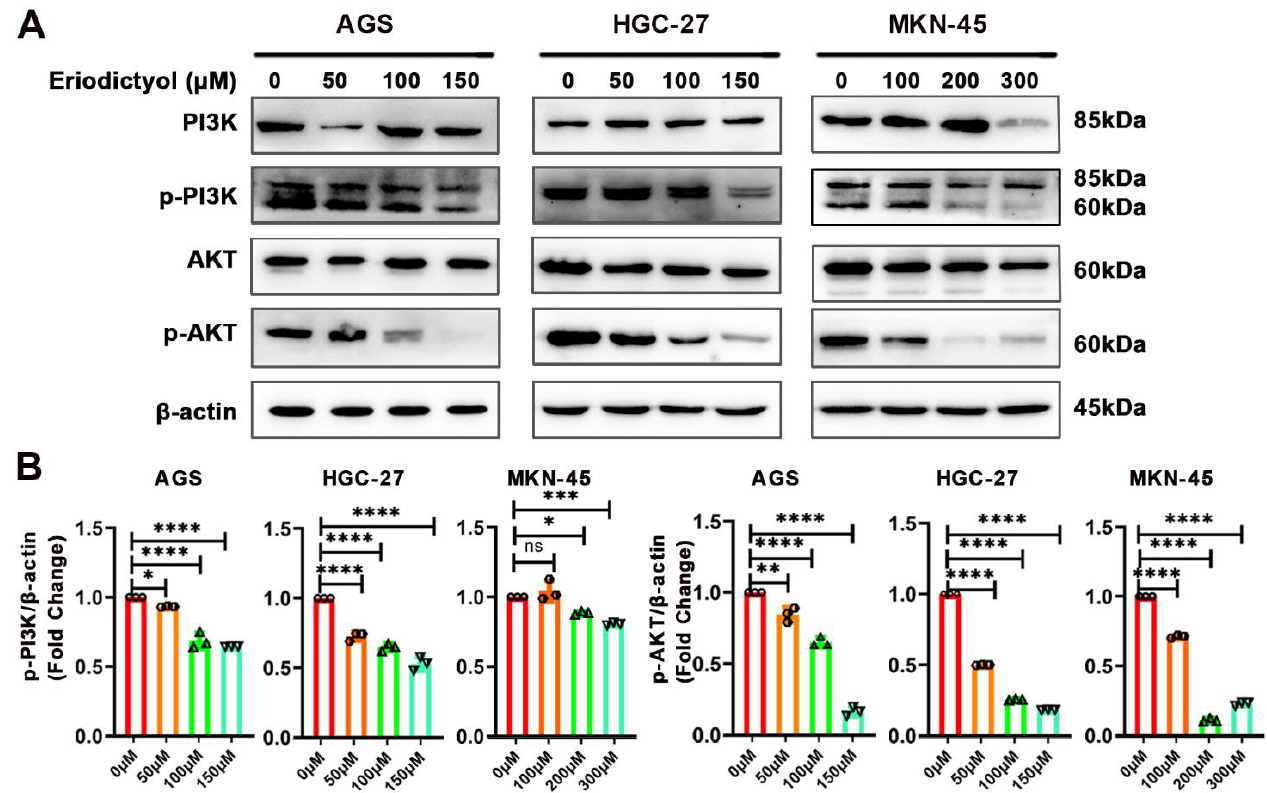
Figure 7. Eriodictyol inhibits GC through the PI3K/AKT pathway. ( A ) The protein levels of PI3K, phosphorylated PI3K, AKT, and phosphorylated AKT were measured with Western blotting. ( B ) The relative protein levels of phosphorylated PI3K and phosphorylated AKT were quantified and are demonstrated as a histogram. Three independent experiments were performed, and data are presented as mean ± SD. ns: no significance, * p < 0.05, ** p < 0.01, *** p < 0.001, **** p < 0.0001.